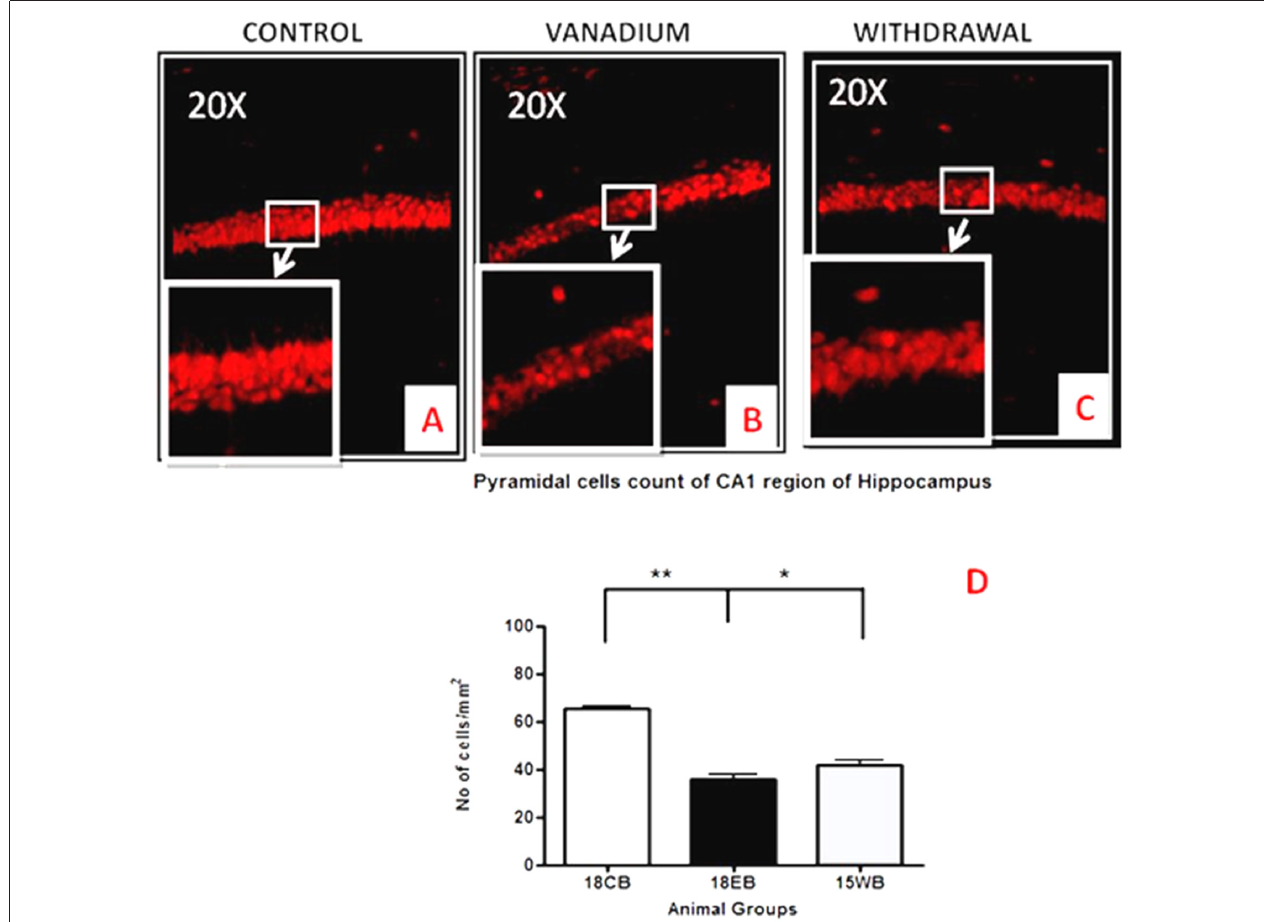
FIGURE 10 | Pyramidal cell loss of the dorsal hippocampal CA1 region after chronic vanadium exposure. NeuN immuno-histochemistry showed evidence of neuronal loss after 18 months of vanadium treatments. Quantitative analysis (D) revealed significant ( ∗∗ P < 0.001) decrease in the no of pyramidal neurones in the exposed groups (B) relative to the control (A) while the withdrawal groups (C) showed reversal effect with significant ( ∗ P < 0.05) increase in neuronal no relative to vanadium exposed groups (B) . Magnification: × 200, inset: ×